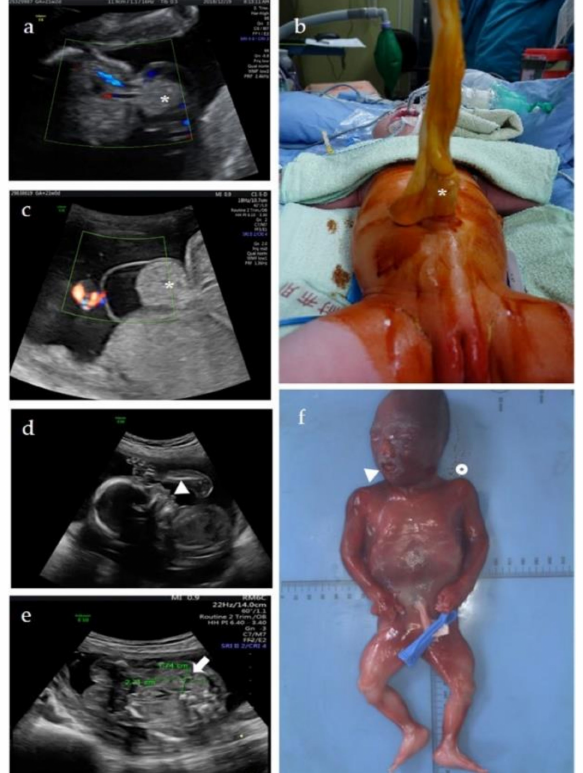
Figure 3. Clinical features of three patients with BWS. Patient 1 ( a , b ): Prenatal ultrasonography identified ( a ) isolated umbilical hernia (star) at GA = 21 weeks and two days. The position of cord insertion was normal and protruding small intestine was noted. ( b ) The umbilical hernia with 3 cm abdominal wall defect and small bowel protruding (star) was identified after birth (GA = 38 weeks). Macrosomia with body weight of 3850 g (96th percentile) was also noted. Patient 2 ( c ): Prenatal ultrasonography identified ( c ) isolated omphalocele (star) at GA = 21 weeks. The cord inserted